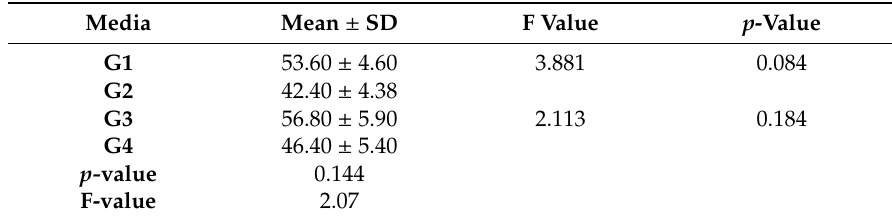
Table 4. Comparison of means germination percentage after 6 weeks of germination. All values are means ± SD.